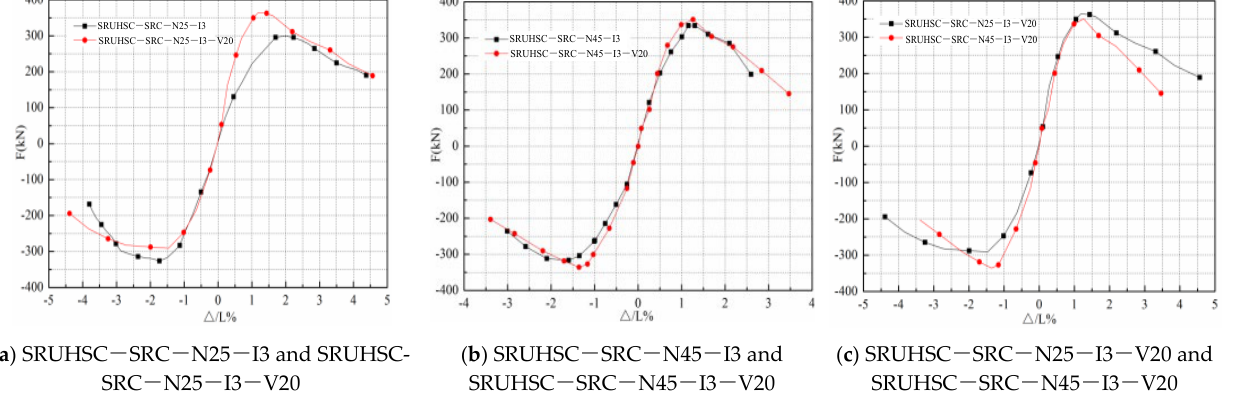
Figure 7. Comparison of skeleton curves.